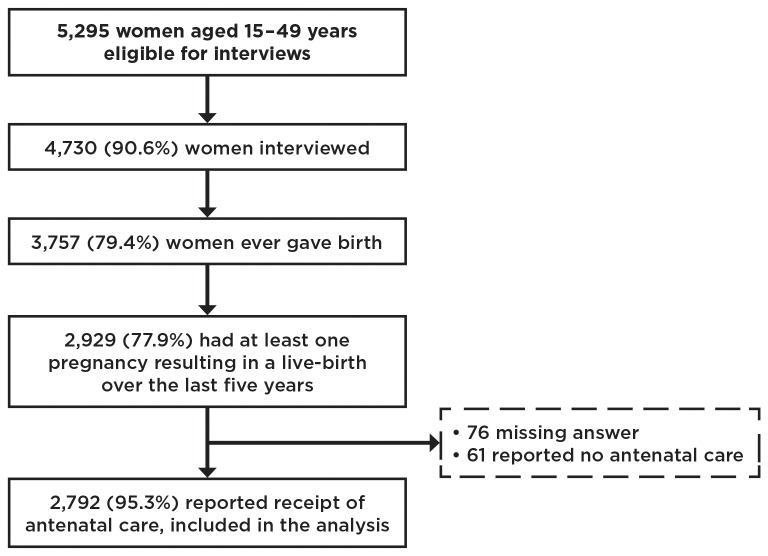
Distribution of women from those eligible to be interviewed to those included in the analysis sample.